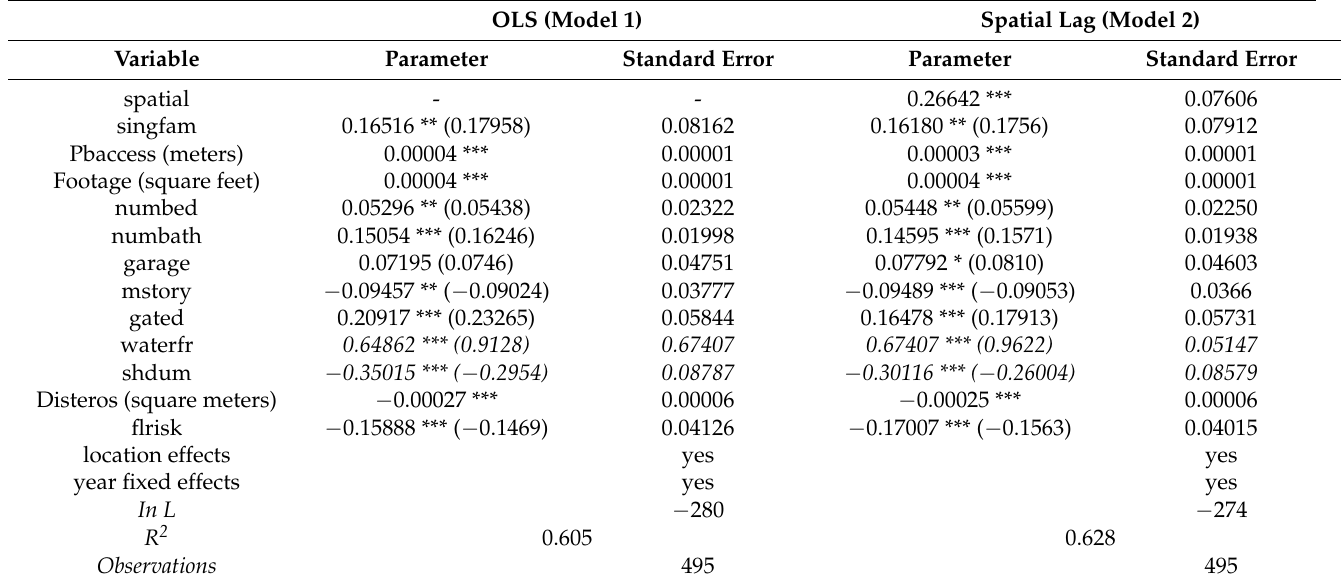
Table 5. Regression